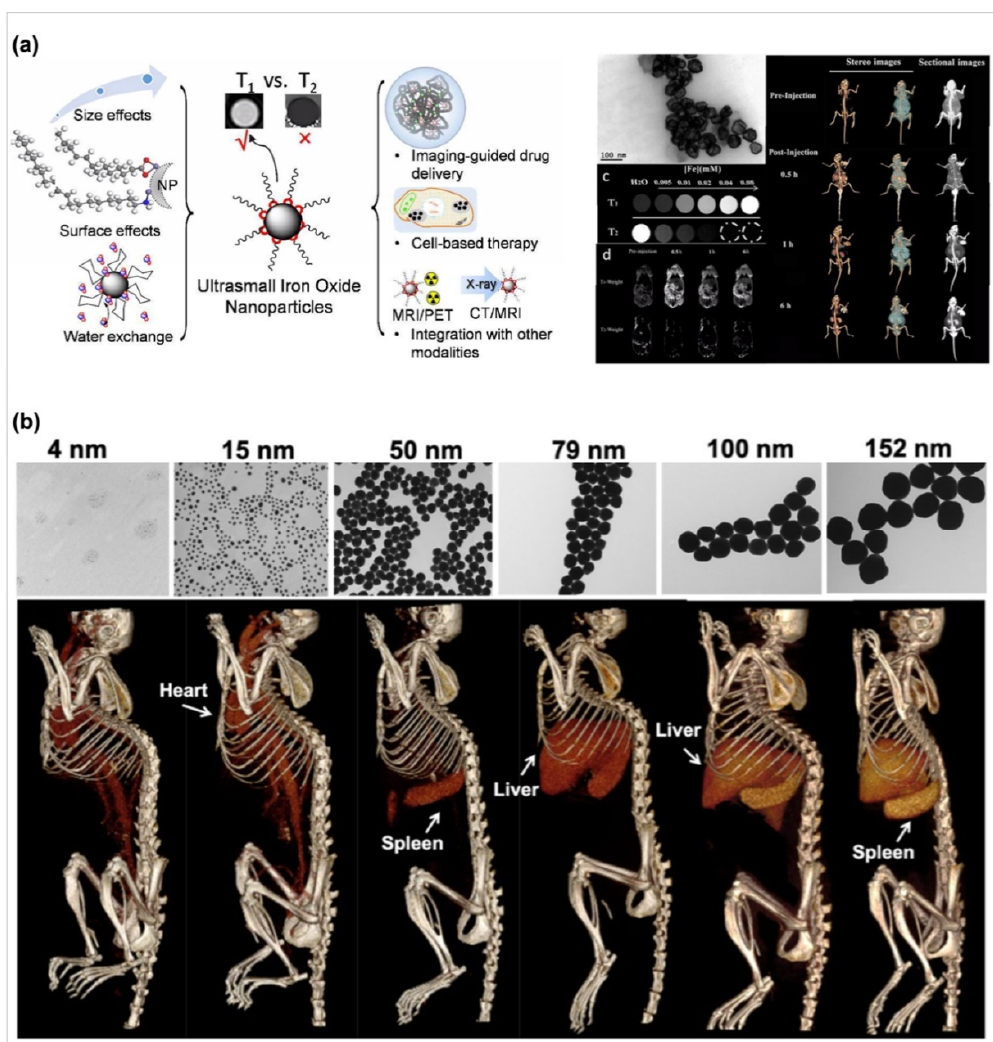
Figure 4. ( a ) Schematic illustrating ultra small iron oxide nanoparticles as T1 magnetic resonance imaging (MRI) contrast agents and possible integration with positron emission tomography (PET) and computed tomography (CT). The ultra small iron oxide nanoparticles further modified with folic acid enable to significant enhance the labels in the tumor and kidney regions in dual CT scan / MRI images, confirming that the nanoparticles could be used as contrast agents for both CT scan / MRI